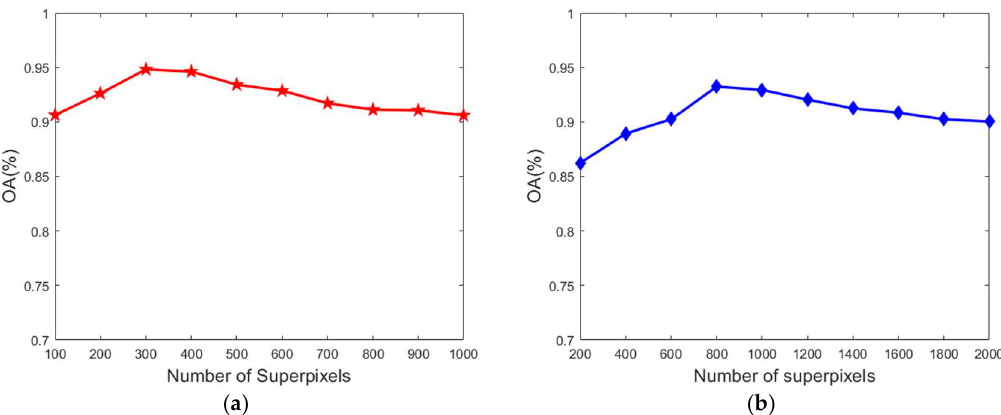
Figure 5. Classification performances from different numbers of superpixels for ( a ) the Indian Pines and ( b ) University of Pavia datasets.